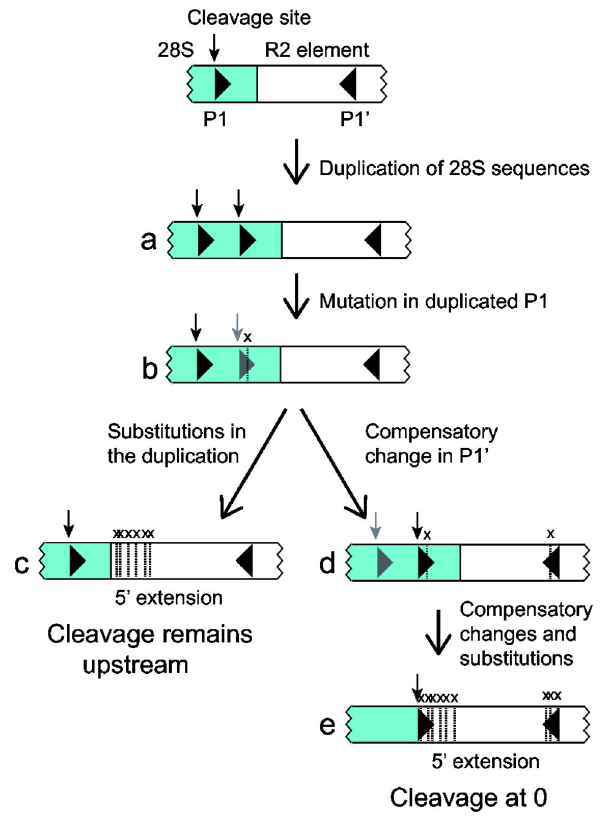
Figure 8. Model for how target site duplications can shift the R2 cleavage site. Diagramed is a typical 28S/R2 5' junction with 28S sequences in blue. The 28S upstream ribozyme self-cleavage site is indicated with a vertical arrow. Indicated with triangles are the upstream (P1) and downstream